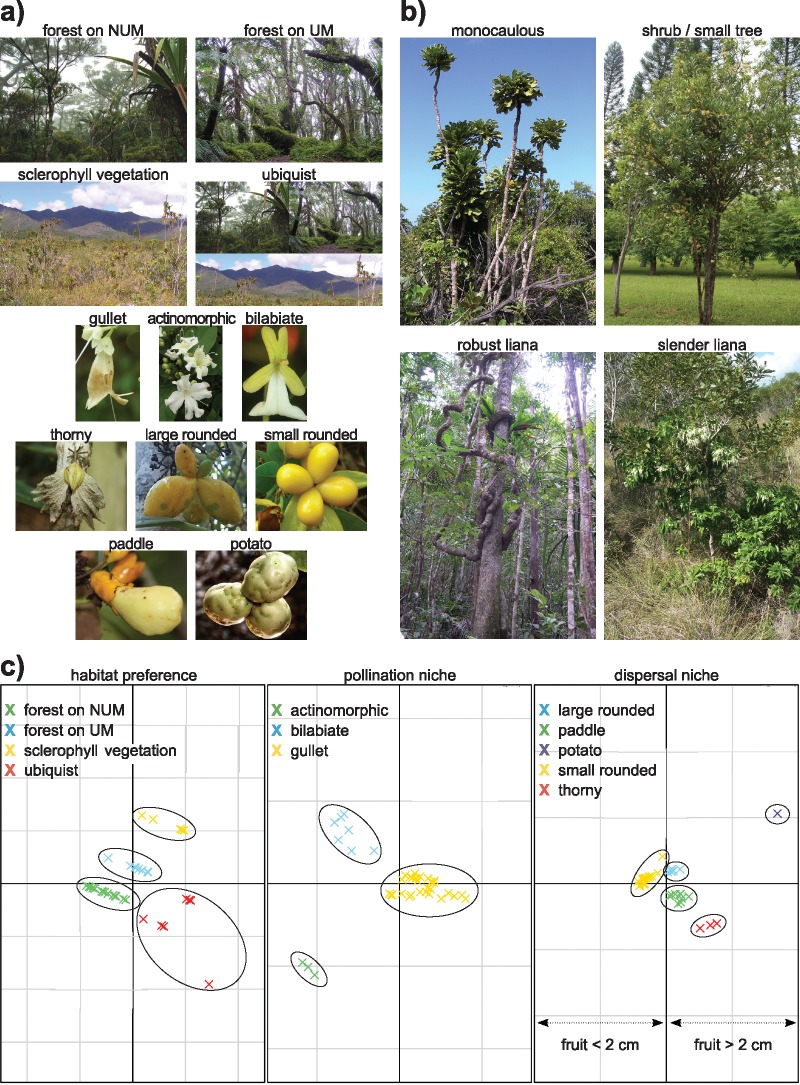
Biological and ecological data sets of Oxera. a) Illustration of habitat preferences and biological syndromes, from top to bottom: habitat preferences (UM = ultramafic soils; NUM \documentclass[12pt]{minimal}
\usepackage{amsmath}
\usepackage{wasysym} 
\usepackage{amsfonts} 
\usepackage{amssymb} 
\usepackage{amsbsy}
\usepackage{upgreek}
\usepackage{mathrsfs}
\setlength{\oddsidemargin}{-69pt}
\begin{document}
}{}$=$\end{document} non-ultramafic soils), pollination niche, and dispersal niche. b) Illustration of life forms. c) Niche syndromes inferred from the Hill and Smith principal component method, according to the first two axes of multivariate analyses.